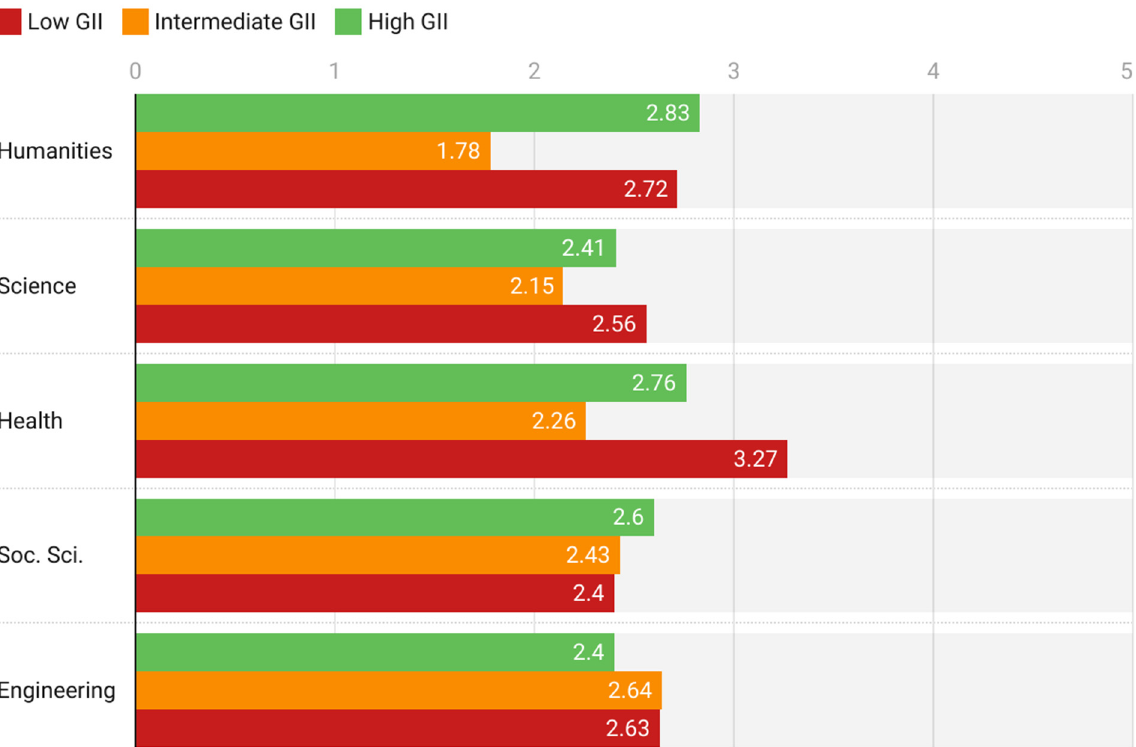
Figure 7. Variations in digital pandemic stress by GII in each area of knowledge.